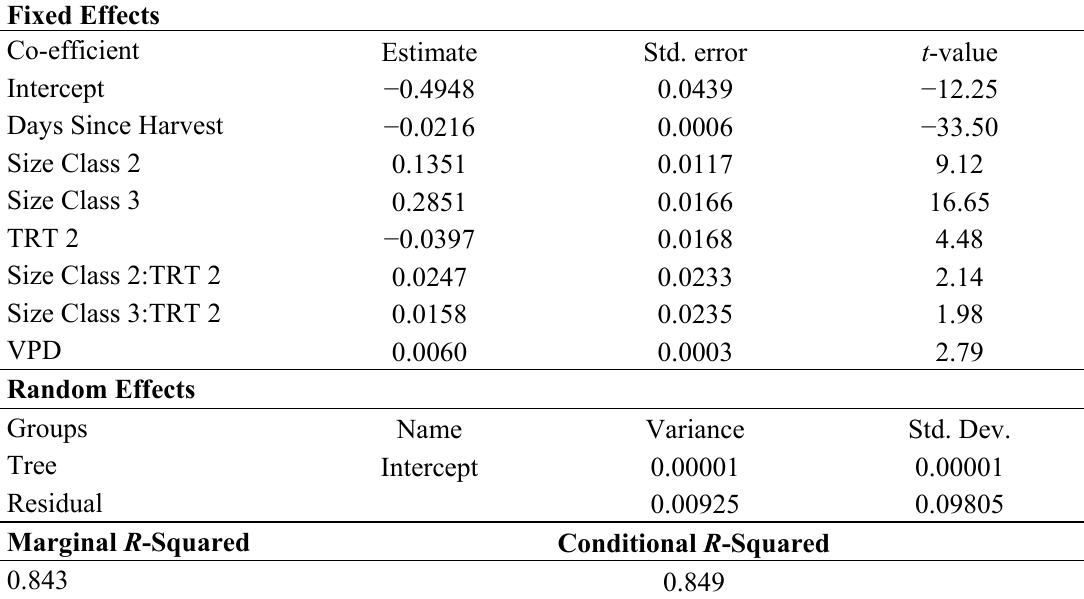
Table 7. The regression values of a generalized linear mixed effects model assessing moisture content of felled stems using Size Class 1, TRT 1, and their interaction as the base